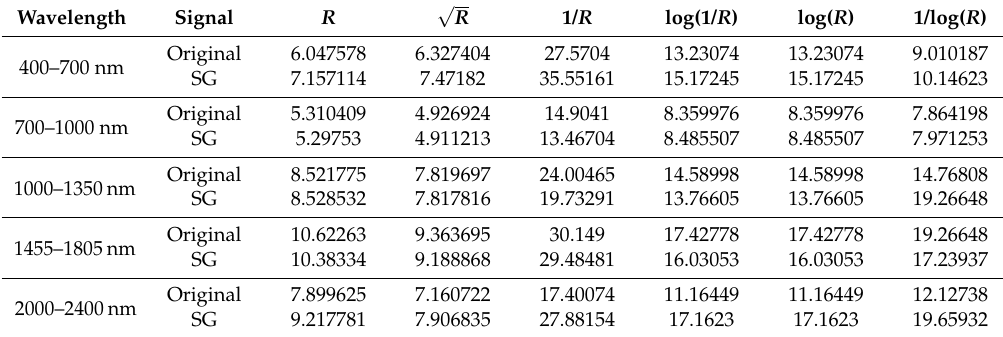
Table 6. The RPD value of the PNN model in Area